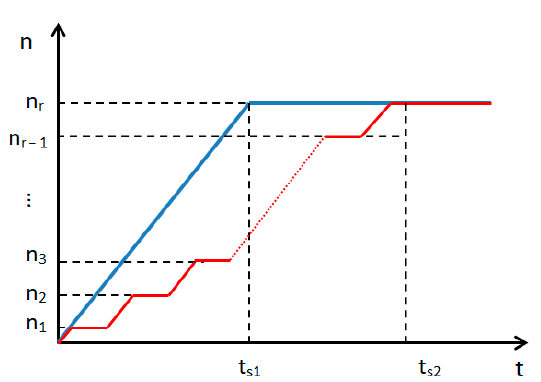
Figure 5. An idealized start-up process of the motor driving the roadheader’s cutterhead used in the process of evaluating the analog filters operating in the measuring paths of electrical quantities.